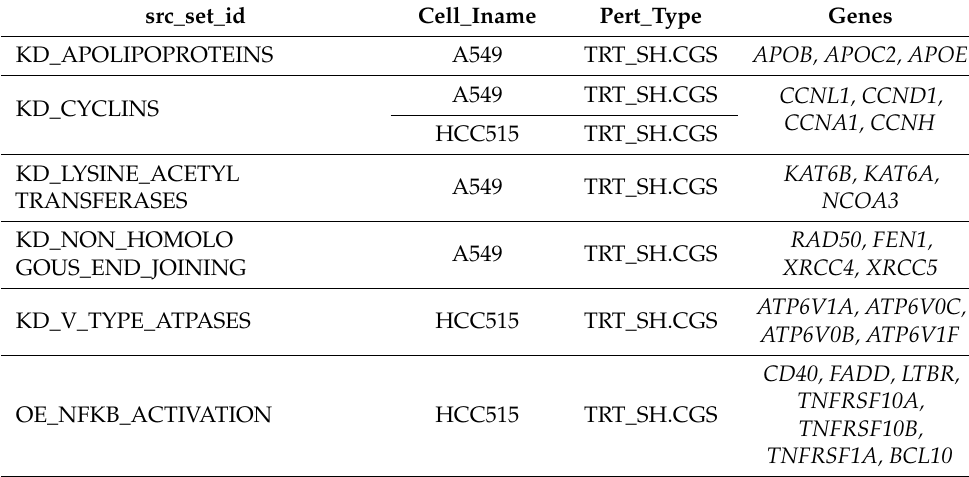
Table 6. The identified significant ( p < 0.05, connectivity score > 0.9) functional pathways from shRNA knock-down experiments in CMap using the up-regulated and down-regulated gene lists in Figure 6A as